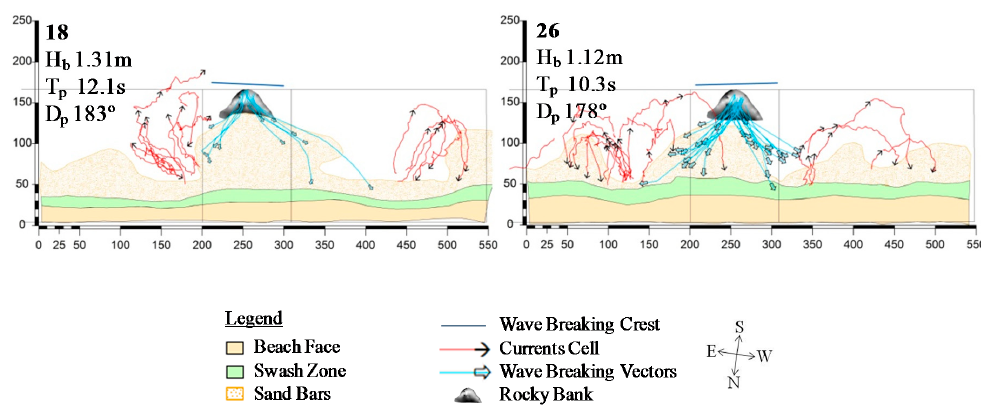
Figure 5. Bidimensional response of the morphological (beach face, swash zone, and sand bars) and hydrodynamic features (currents cell-tracked and wave breaking vector tracked) in the Reserva Beach system. The configuration of these 10 cases was grouped due to the depositional morphological feature in the lee of the rocky bank. The onshore sand bars depth is − 1.5 m, relative to the mean sea level for each day. The wave data parameters (H b , T p and D p ) during each case are also indicated.